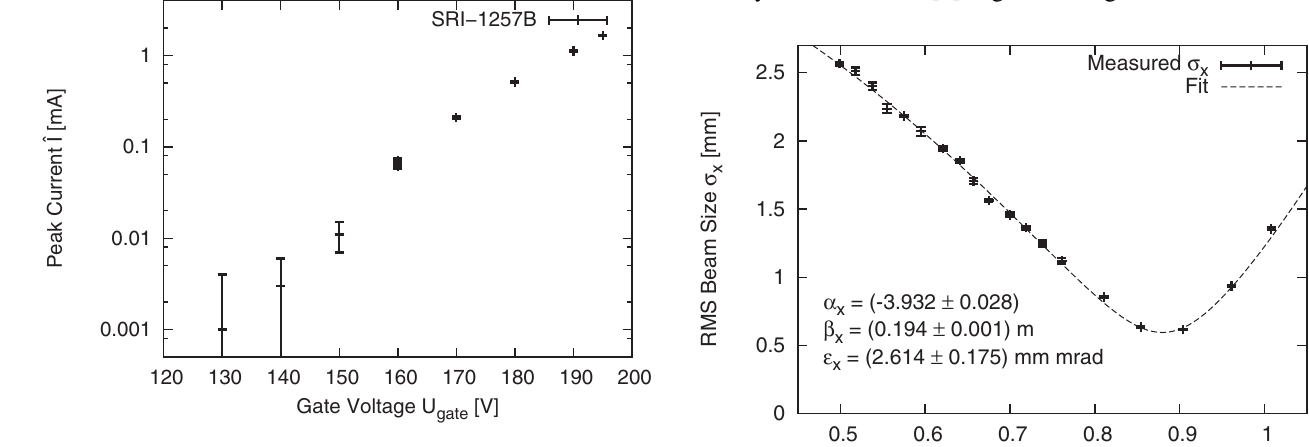
FIG. 2. FEA performance calibration using 40 kV accelerating HV, a pulse length of 100 ns, and a repetition rate of 100 Hz. Above 200 V emission became unstable and triggered HV breakdown.